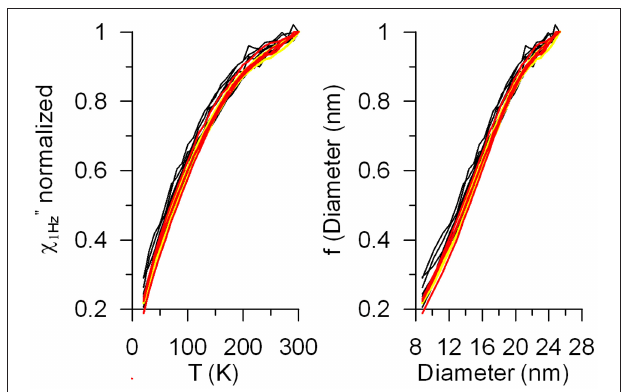
FIGURE 5 | Out-of-phase susceptibility at 1Hz vs. temperature ′′ ( χ 1Hz (T)) (left) and grain size distribution (right) estimated from χ for loess-paleosol samples (yellow), red-clay samples during the interval 4.8–4.1Ma (black), and red-clay samples outside the interval 4.8–4.1 Ma (red). The grain size distribution of ferrimagnetic minerals